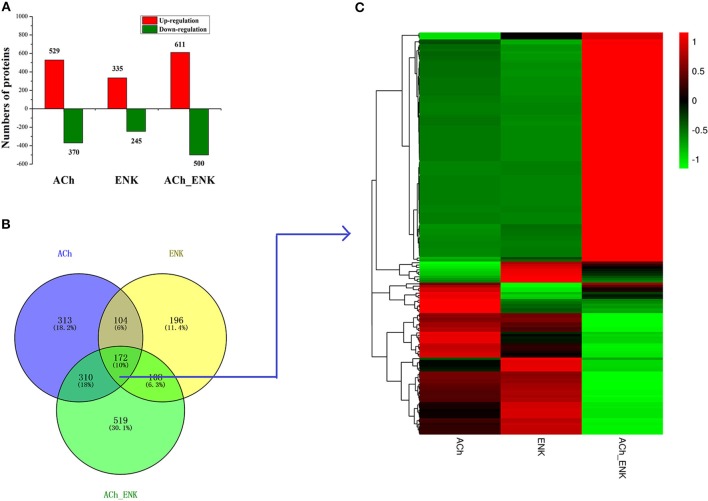
Number of differentially expressed proteins under ACh, ENK, and ACh_ENK treatments. (A) A total of 4,956 differentially expressed proteins were identified in all three neurotransmitter treatment groups compared with that in the SW group. (B) A Venn diagram showing the common and unique expressed proteins and (C) hierarchical clustering of the 172 differentially expressed proteins responsive to all three treatments.